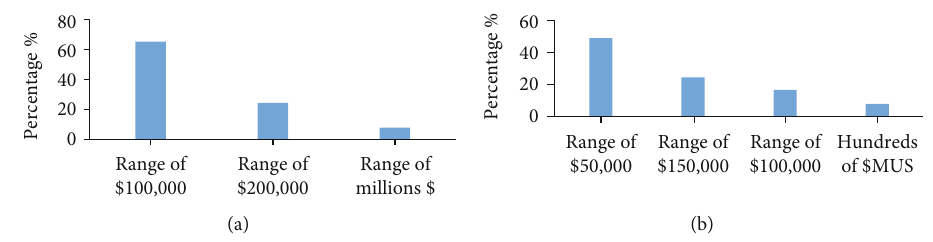
Figure 1: (a) Revenues and (b) assets of the questioned domestic enterprises working in the fi eld of RE.